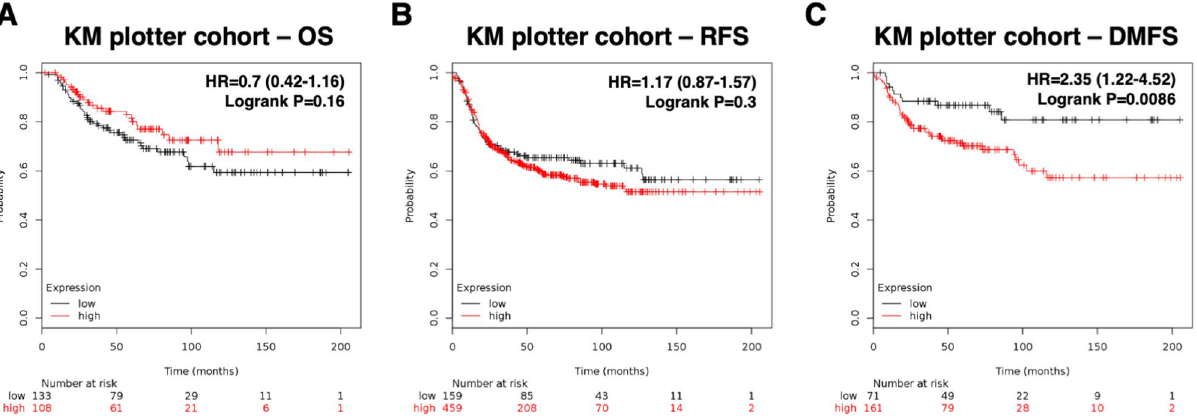
Figure 2. Overexpression of GPNMB mRNA correlates with worse DMFS. Kaplan–Meier analysis of the influence of GPNMB mRNA expression on ( A ) OS, P = 0.16. ( B ) RFS, P = 0.3. ( C ) DMFS, P < 0.01 in patients with TNBC from the public database (http:// kmplot. com).